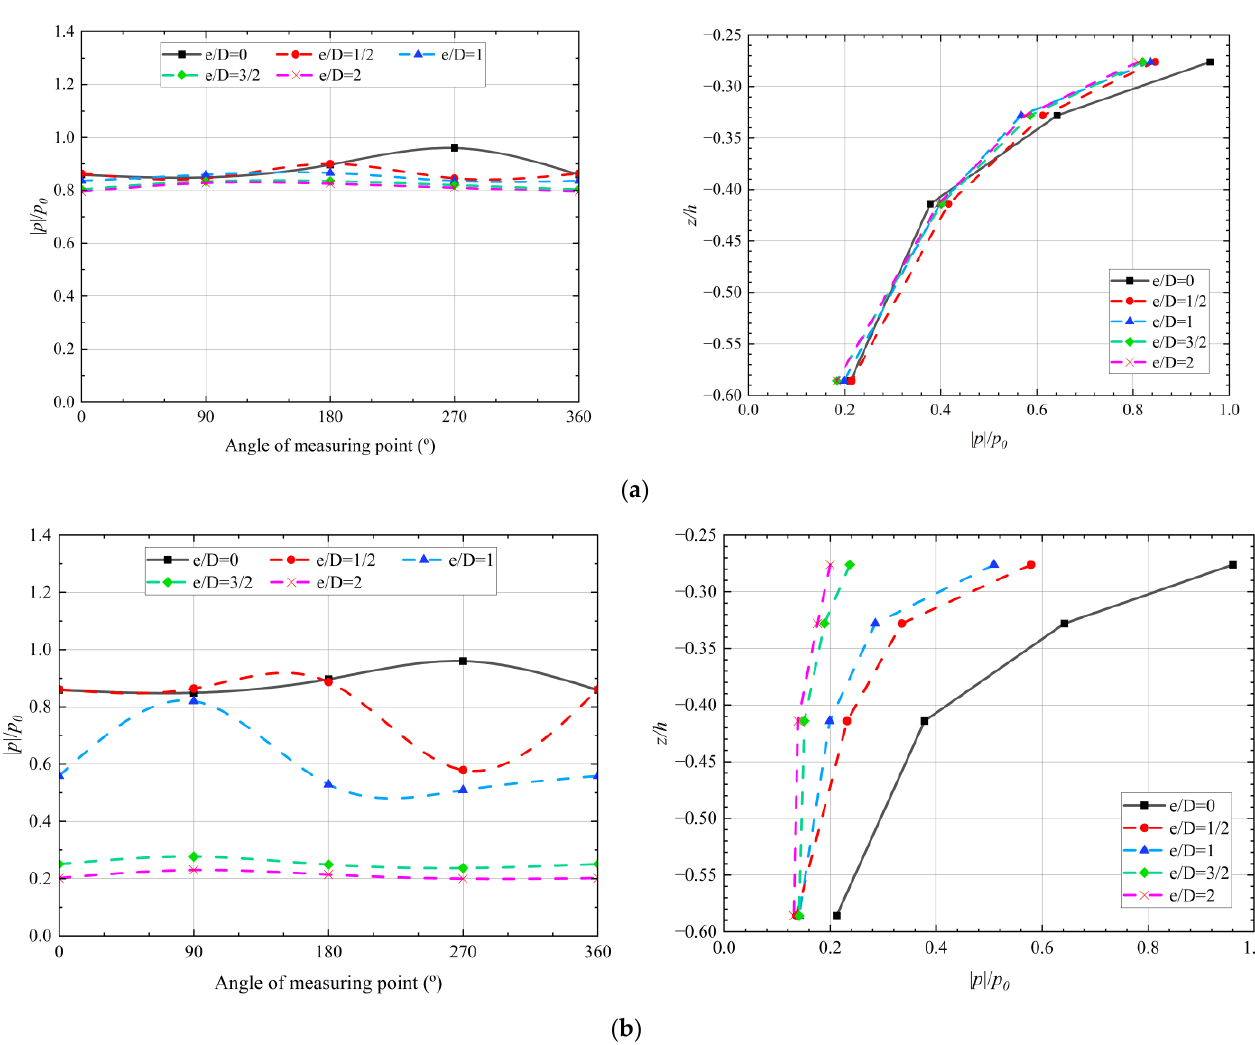
Figure A5. Variation of the dimensionless pore pressure amplitude around the pipeline with different backfill depths within the medium sand and silt seabed. ( a ) 𝑑 50 = 0.30 mm; ( b ) 𝑑 50 = 0.045 mm.